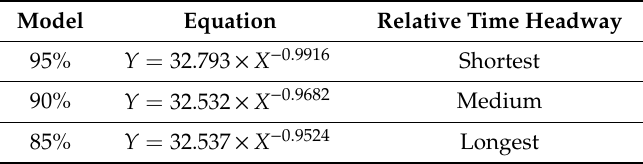
Table 2. Polynomial dynamic speed time headway models